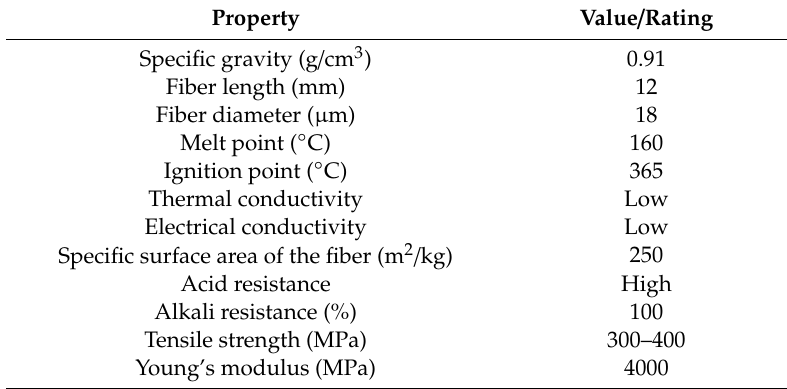
Table 1. Technical specifications of polypropylene fibers (100% polypropylene as a chemical base) used for the reinforcement of shear walls (from the producer’s datasheet).